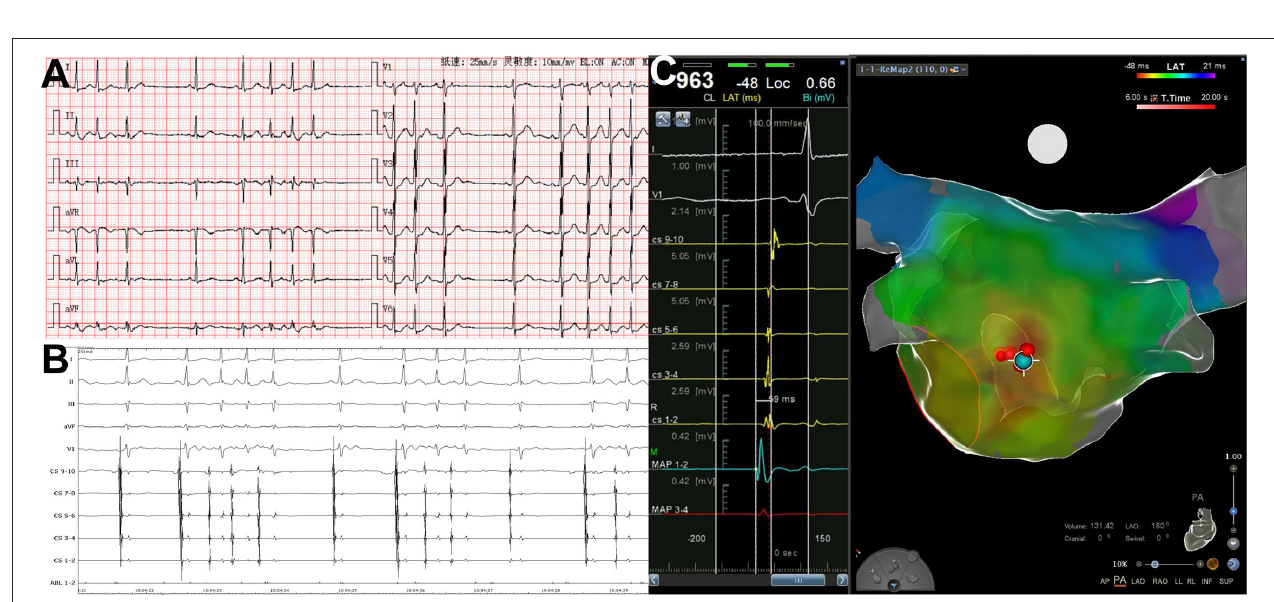
FIGURE 3 | Schematic diagram of left anterior oblique (A) and postero-anterior (B) views of dual atria showing the successful ablation target sites in 43 patients. Each black dot represented one ectopic focus. The yellow dot indicated His bundle. SVC, superior vena cava; IVC, inferior vena cava; RA, right atrium; CT, crista terminalis; CS, coronary sinus; TA, tricuspid annulus; IS, interatrial septum; LSPV, left superior pulmonary vein; RSPV, right superior pulmonary vein; MA, mitral annulus; LA, left atrium; LAA, left atrial appendage; AV, aortic valve.